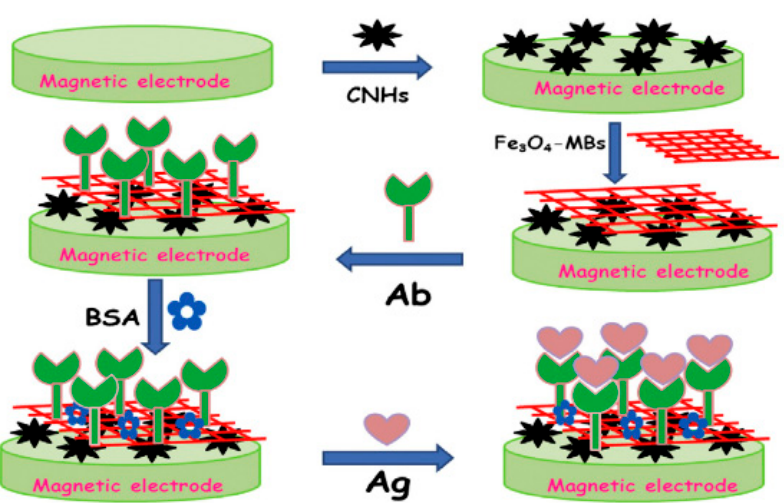
Figure 4. Schematic of the formation of sensing layer over the immunosensor using Bovine serum albumin (BSA), Aflatoxin B1 (Ab) and carbon nanohorns (CNHs), Magnetic beads (MBs) Fe 3 O 4